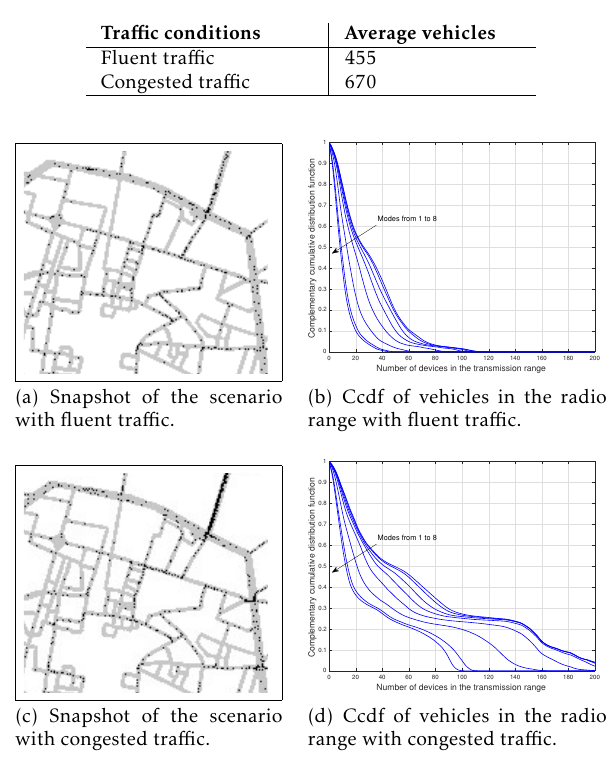
Figure 1. Example snapshots of the road network and simulated traffic under fluent and congested conditions and corresponding complementary cumulative distribution function (ccdf) of the number of vehicles in the radio range of the OBUs for the various